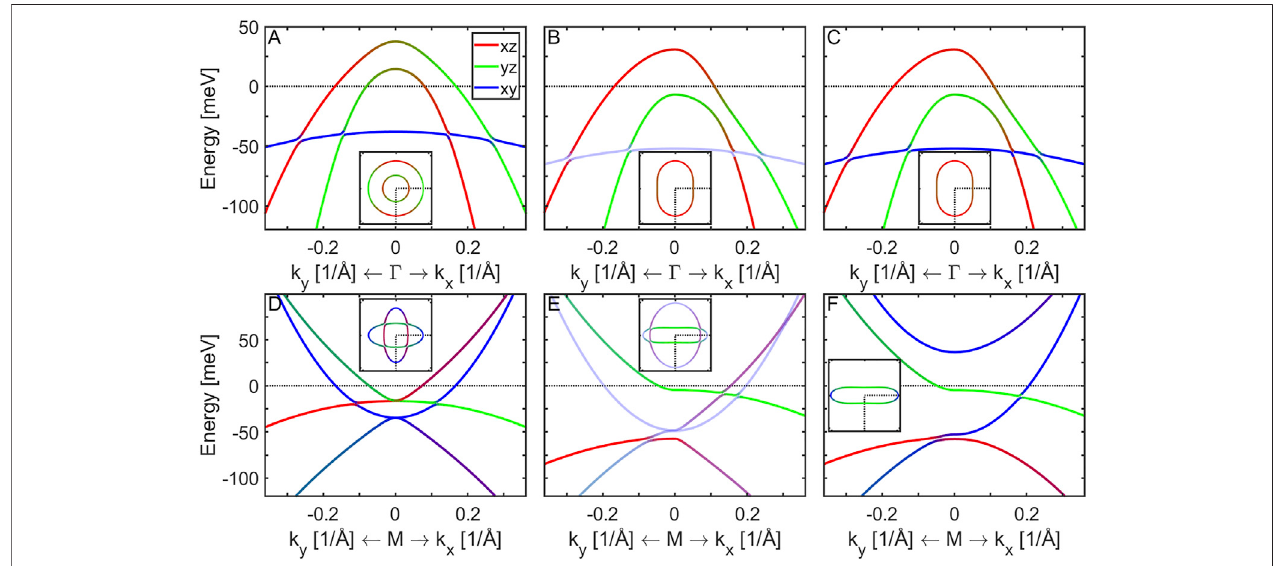
FIGURE 1 | The band structure of the 2-Fe Brillouin zone around the Γ and the M point is presented comparing the tetragonal state and scenarios A and B for the nematic state in FeSe as described in the text. Panels (A) – (C) show the energy dispersion near the Γ point in the tetragonal state (A) and two nematic states without (Scenario A) (B) and with (C) non-local d xy nematicity (Scenario B). Panels (D – F) display the corresponding band structure near the M point. Red, green and blue colors illustratethe orbitalweights ofthe d xz , d yz and d xy Fe-orbitals,respectively. Theinsets showthe corresponding Fermisurface and demonstrate thecuts performed. Shading according to the d xy orbital weight in panels (B) and (E) re fl ects the Z -factors used in